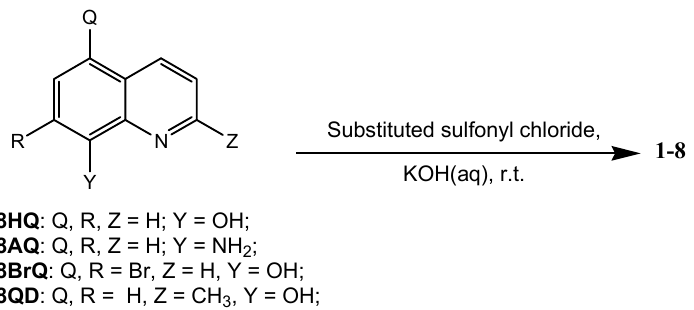
Table 1. Bioactivity of the tested compounds ( 1–3 ) against liver cancer cell line Hep3B and the related docking results.